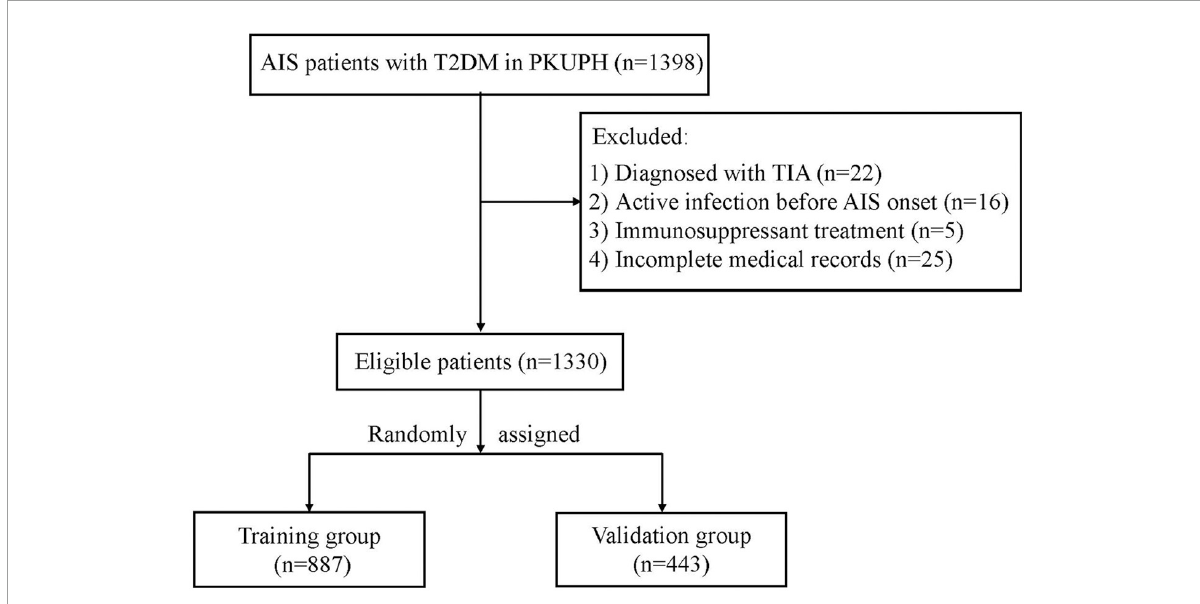
FIGURE1 Study flow diagram. AIS, acute ischemic stroke; T2DM, type 2 diabetes mellitus; PKUPH, Peking University People’s Hospital; TIA, transient ischemic attack.